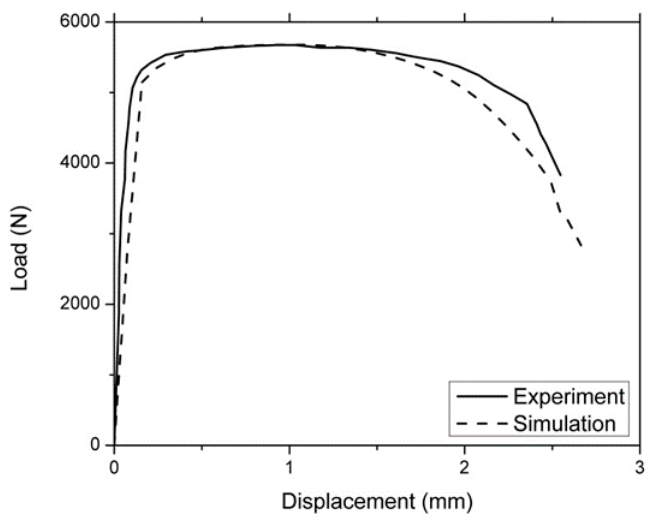
Figure 13. Load–displacement response for the asymmetrically notched sample. Experimental data by Ambati et al. [15].